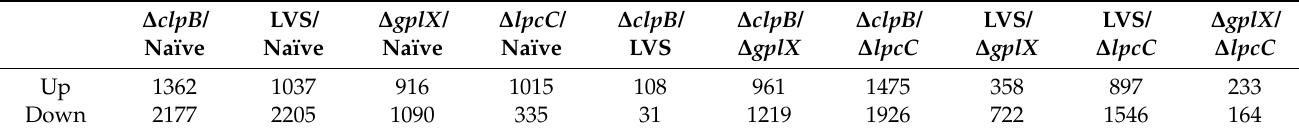
Table 2. Number of differentially expressed genes between each